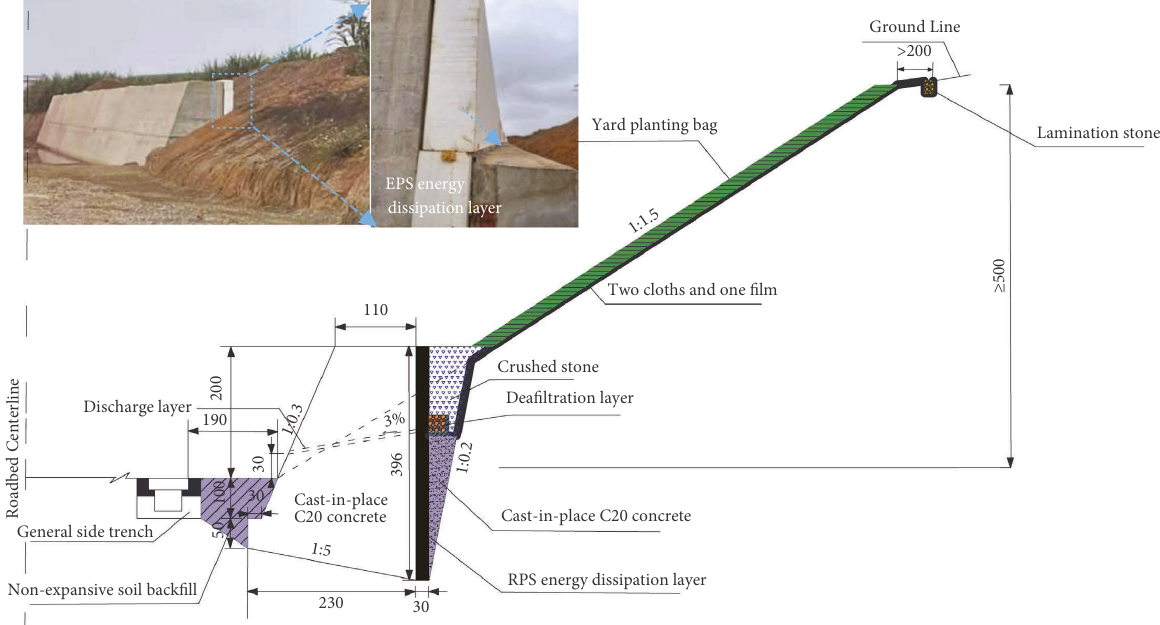
Figure 17: EPS energy dissipation retaining